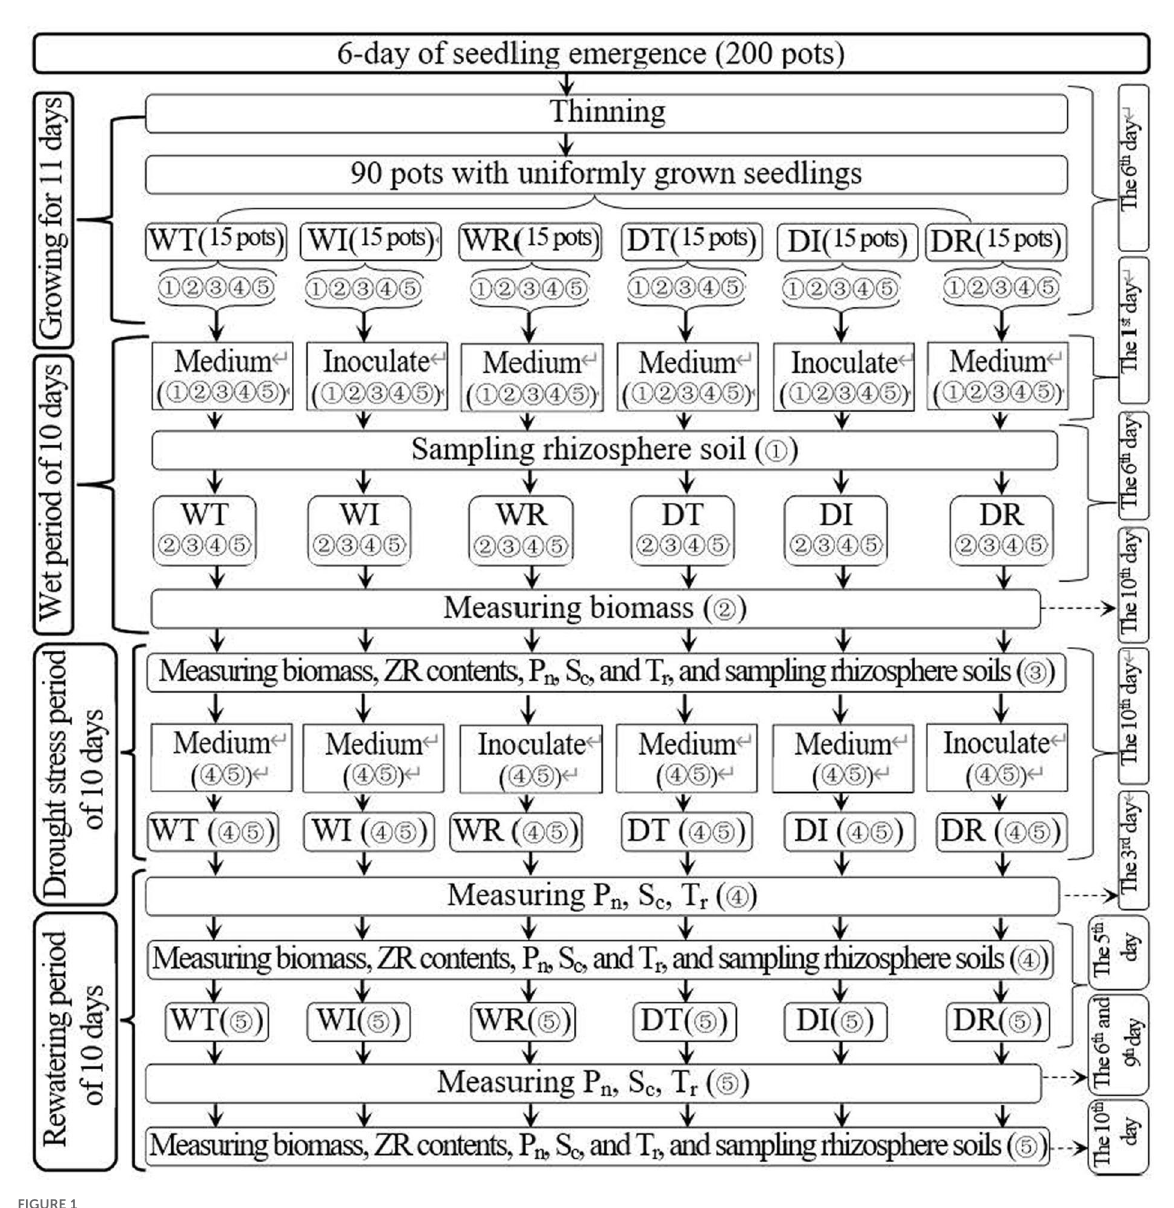
corn biomass, zeatin riboside (ZR) content, net photosynthetic rate (P n ), transpiration rate (T r ), and stomatal conductance (S c ) were measured in the third subgroup of each treatment, and rhizosphere soils that were used for the measurement of soil + − nitrification rate, soil NH , and NO contents and AOB stain 4 3 number were also